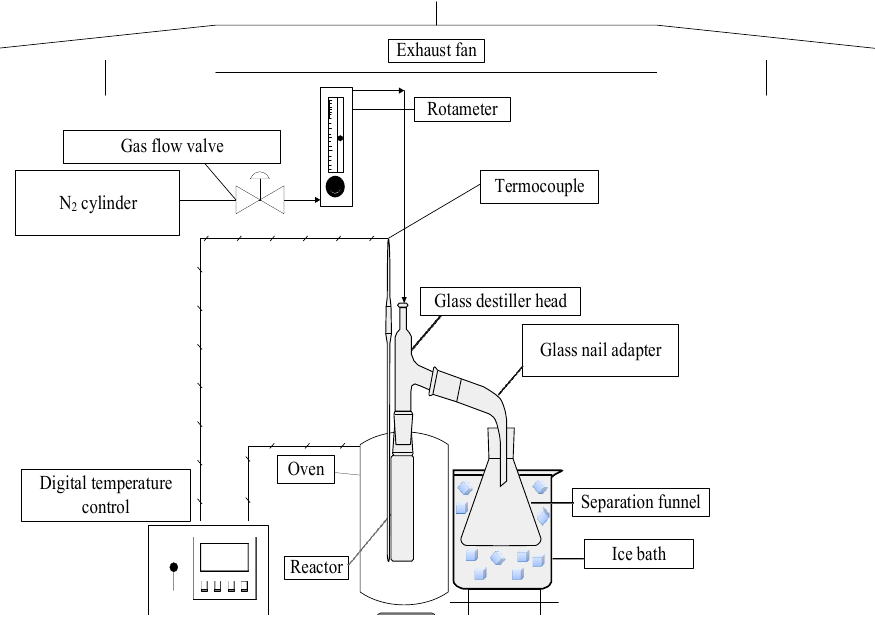
Figure 4. Schema of laboratory scale borosilicate glass reactor.